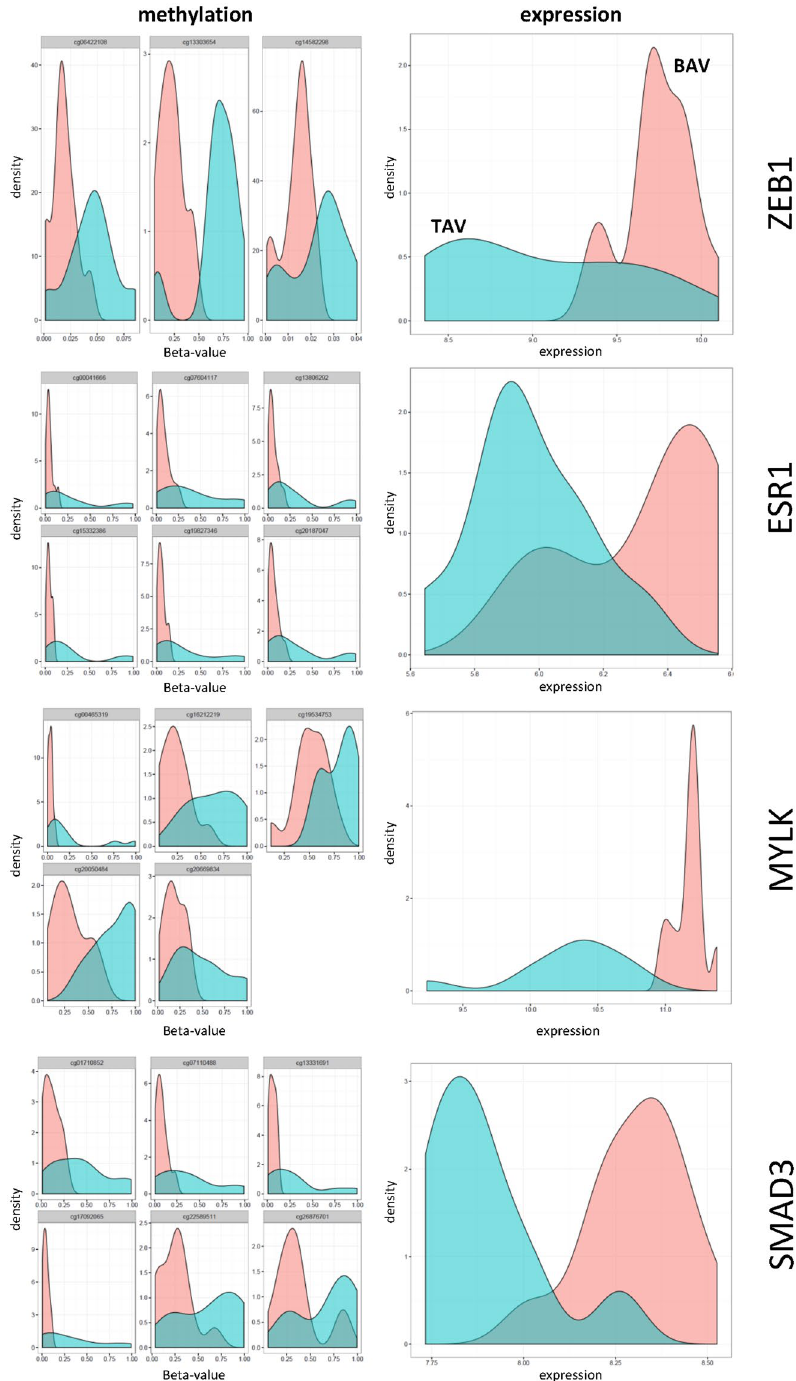
Figure 3. DNA methylation and gene expression density distribution plots of EMT related genes, BAV and TAV dilated aortas. DNA methylation and gene expression levels are measured in the same ascending aortic biopsy. N = 12 BAV (pink) and N = 12 TAV (blue). Methylation data is presented as beta